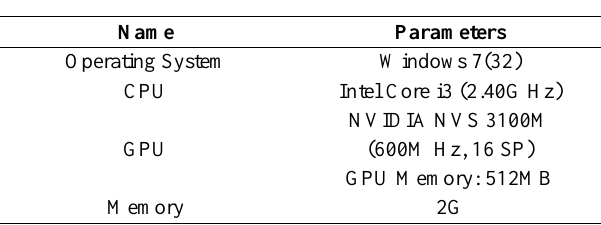
Table 1. Parameters of experiments environments